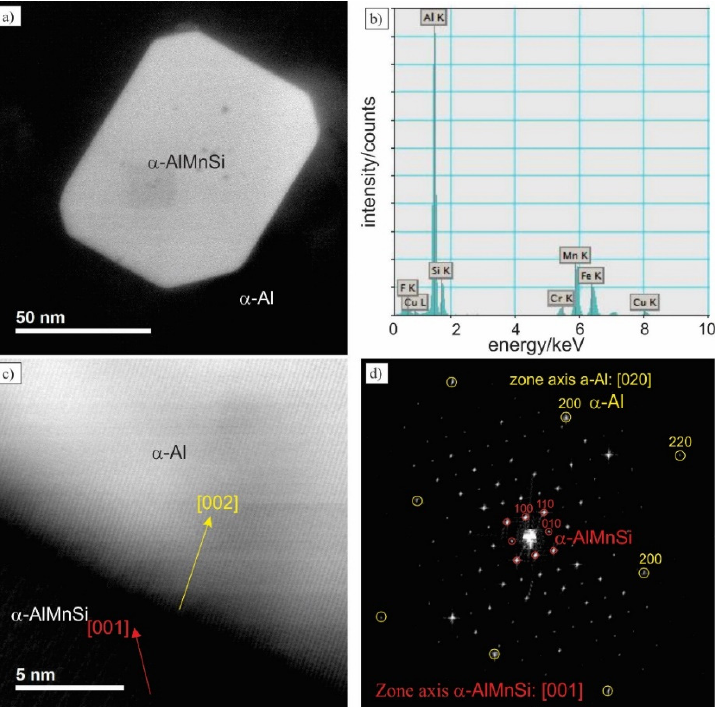
and the distribution of dispersoids. ( a ) Bright-field micrograph and ( b ) HAADF micrograph.